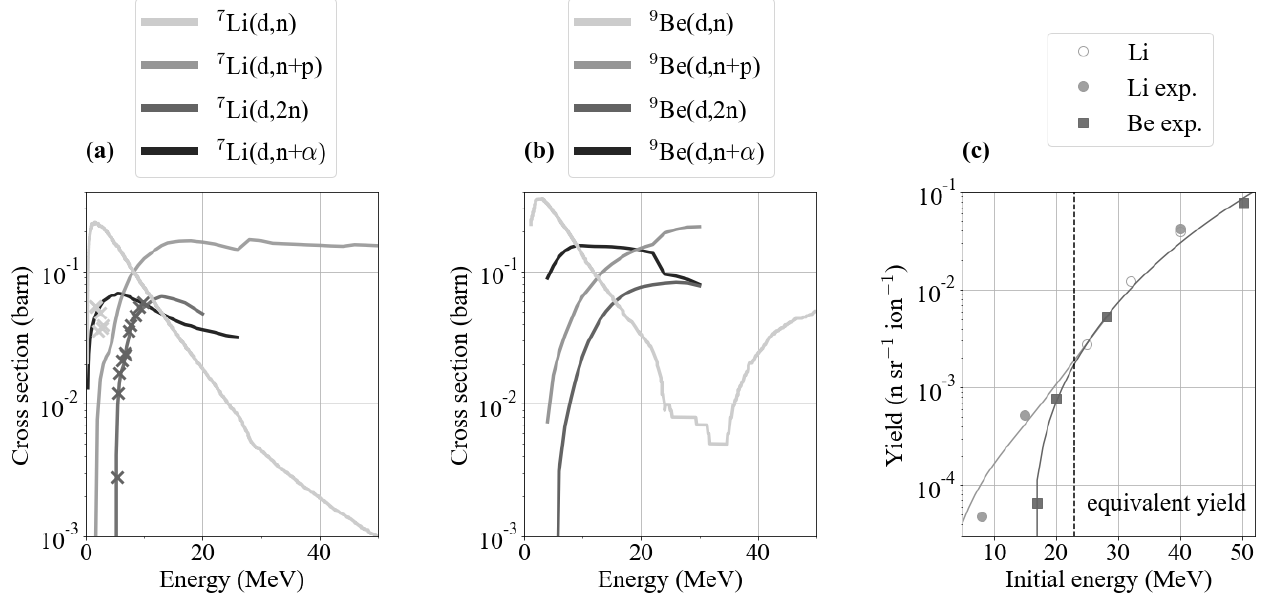
Figure 4. ( a ) Simulated neutron production cross sections (solid lines) [79–81] and corresponding experimental values (crosses) for lithium [82–84], ( b ) simulated neutron production cross sections for beryllium [79–81,85] and ( c ) experimental neutron yields (full circles) for lithium (8, 12, and 15 MeV from [86], 40 MeV from [87]) and for beryllium (squares) from [88] measured with a monoenergetic deuteron beam produced by an accelerator impinging on a thick converter target as well as simulation studies (empty circles) using Monte Carlo codes [89,90]. The plotted lines are a guide to the eye for the two different materials. To the right of the dashed line lithium and beryllium show equivalent neutron yield for incident deuterons with the same energy. (adapted from